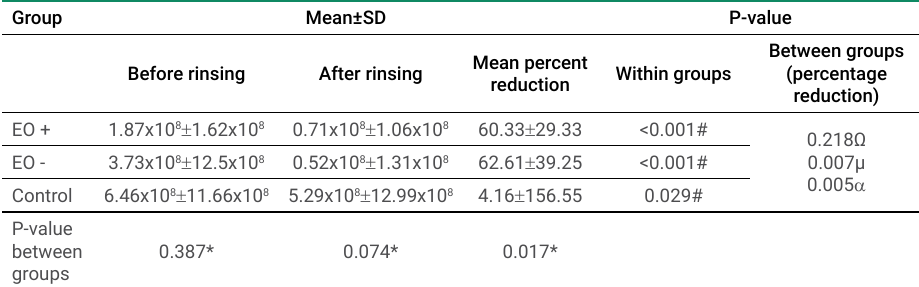
Table 1. Mean±Standard deviation values for each time point and groups of the colony forming-units of total aerobes. Group Mean±SD P-value Before